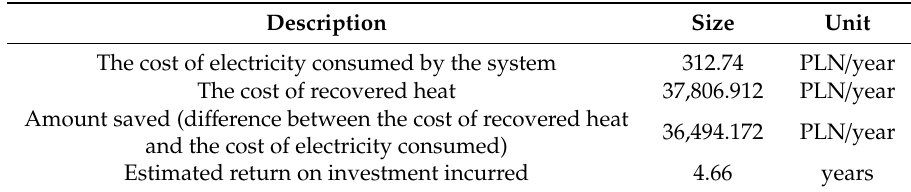
Table 6. Cost analysis (heat recovery plant from wastewater with a recuperator).